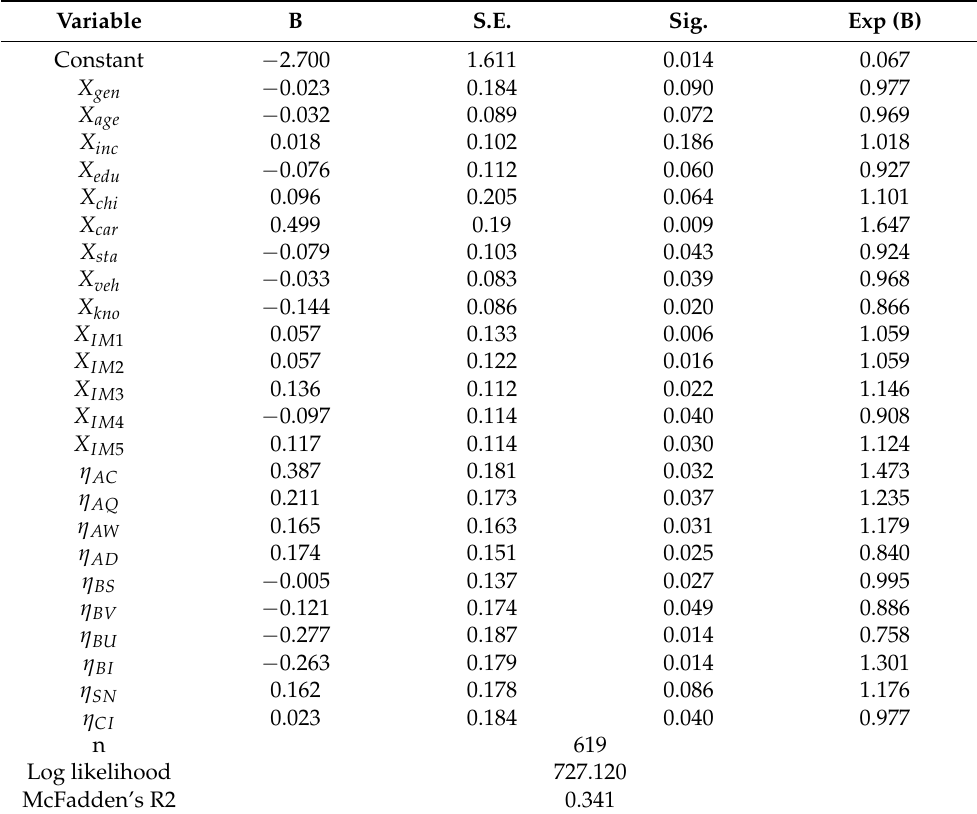
Table 8. Parameter fitting results of logit model without latent attitude